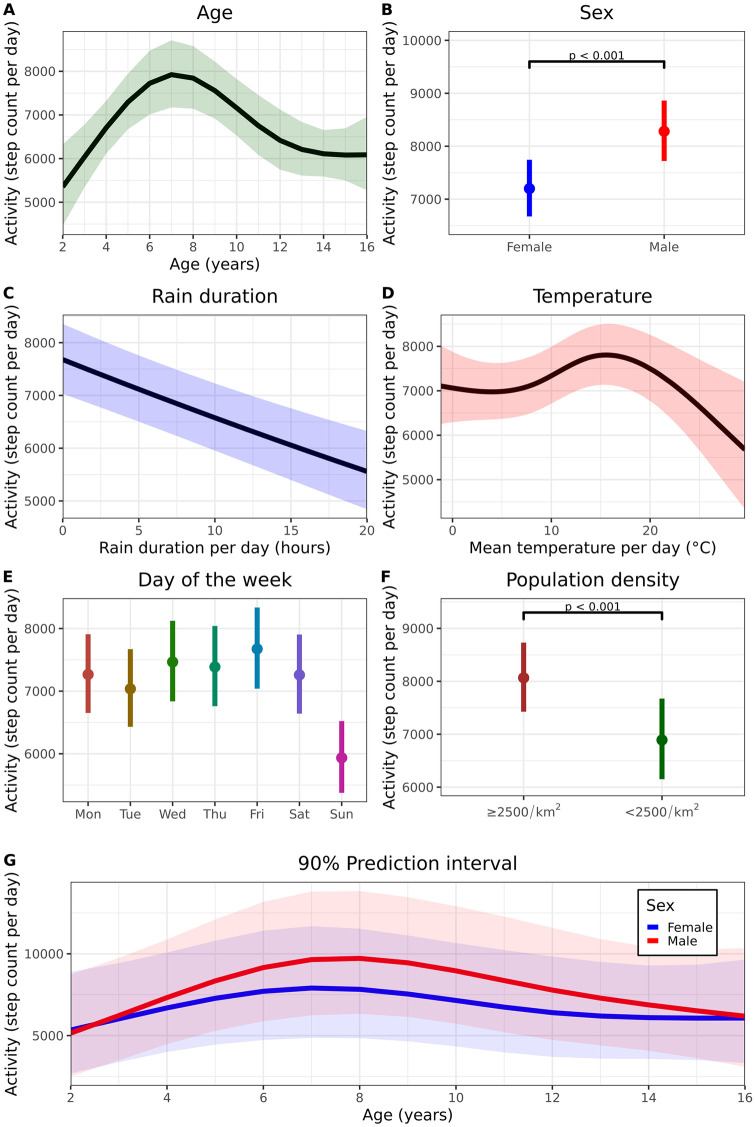
Factors related to daily physical activity and reference values.A. Relationship between mean daily physical activity (95% CI) and age. B. Relationship between daily PA and sex. The interaction between age and sex was excluded from the model for this graph only. C. Relationship between daily rain duration and physical activity. D: estimated mean (95% CI) daily PA with varying ambient temperature. E: estimated mean (95% CI) physical activity for each day of the week. F: estimated mean daily PA for children living in a highly urbanized area (> 2000 people/km2) or a less urbanized area (< 2000 people/km2). G. 90% prediction interval of daily PA stratified by age and sex. Wear time (100%), rain duration (2h) and temperature (11°C) are held constant. Personalized predictions can be made using the model coefficients in S4 Table.